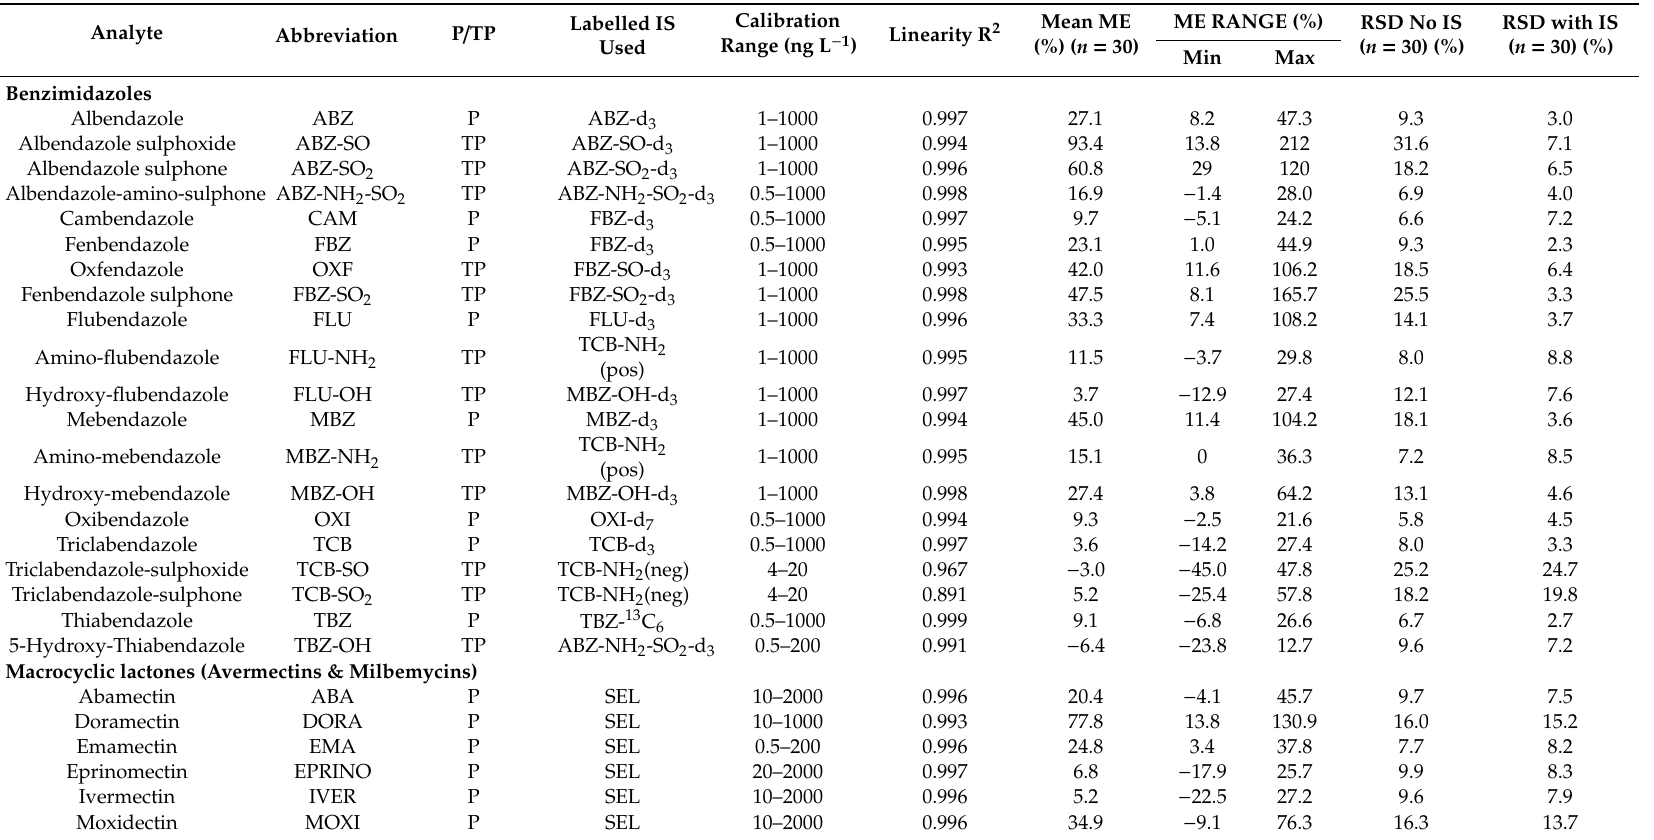
Table 2. Calibration range, mean linearity (of n = 5 runs), and results of matrix e ff ects (ME) ( n = 30) for each of the 40 anthelmintic